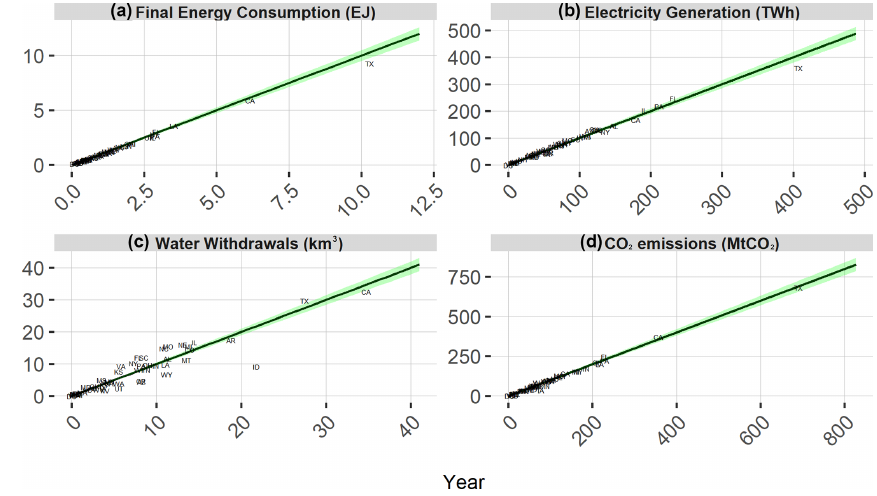
Figure 12. Comparison of state-level historical results (2015) from GCAM-USA to historical data for (a) final energy consumption, (b) elec- tricity generation, (c) water withdrawals, and (d) energy system CO 2 emissions. The line in each figure is a one-to-one line indicating an exact match between historical data and model outcomes; the green band around this line corresponds to a ± 5% deviation from historical data. Individual state results are indicated by the position of the corresponding state abbreviation. Note that the units and axis scales vary by panel.